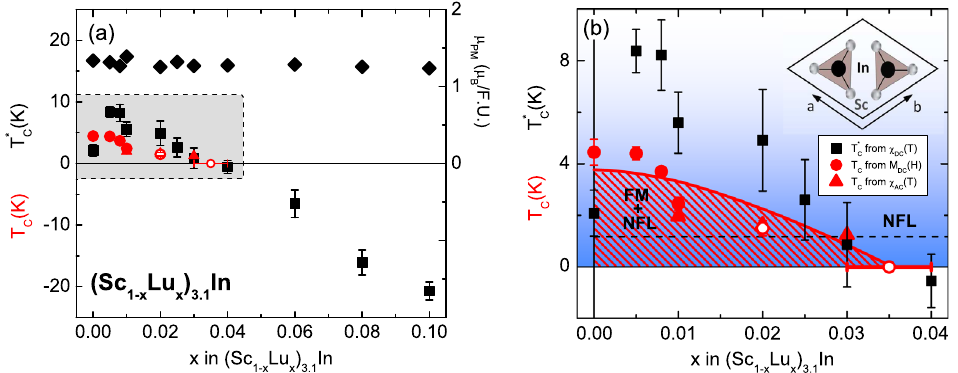
Þ 0 ≤ x ≤ 0 . 10 , with the Weiss-like temperature T (cid:4) Lu (squares, left axis), the 3 . 1 In for x x C (diamonds, right axis). (b) Enlarged T − x phase diagram for PM In unit cell shown in the inset. The horizontal line at T ¼ 1 . 17 K . 1 estimates extrapolated from accessible C